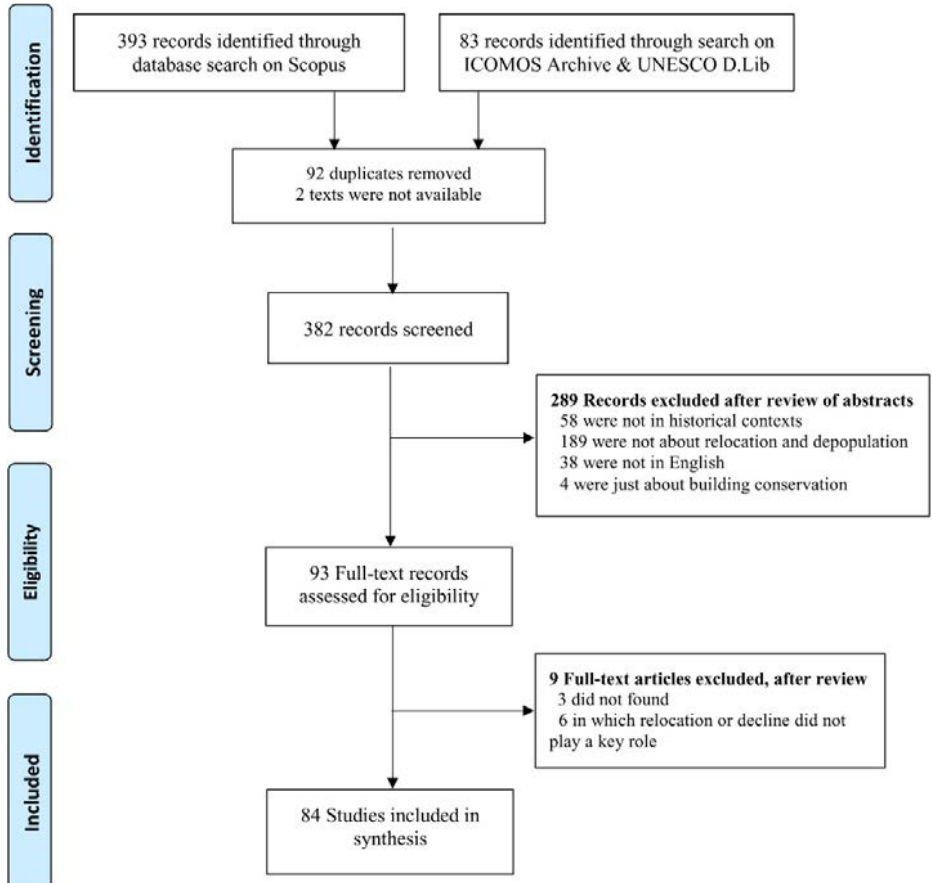
Fig. 1: PRISMA diagram of the literature search and final inclusion of publications